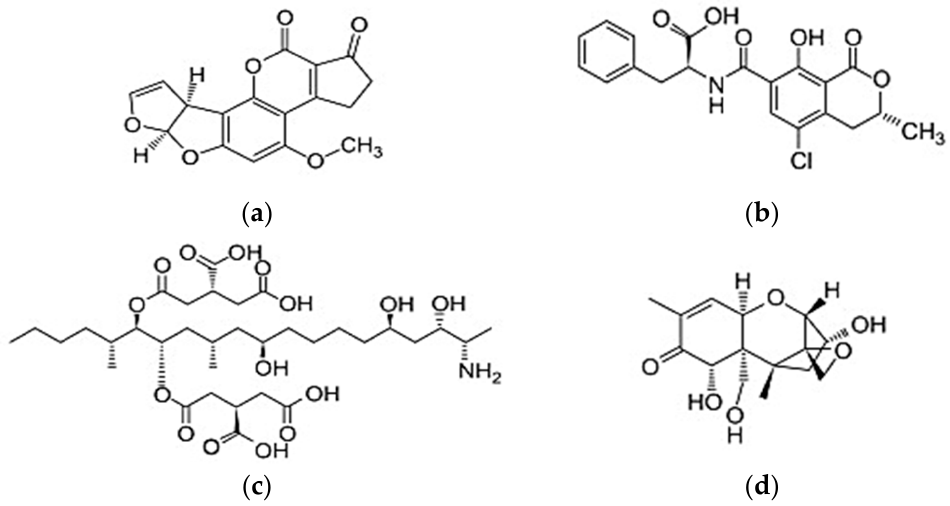
Figure 1. Structure of the four mycotoxins detected in the current study: ( a ) Aflatoxin B1; ( b ) Ochratoxin A; ( c ) Fumonisin B1, and ( d )